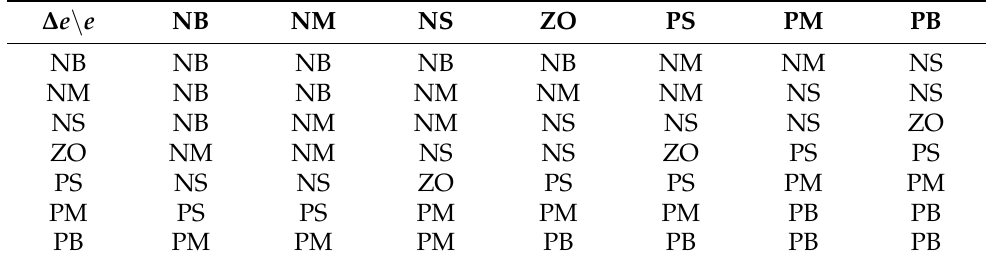
Table 2. Rule base of ∆𝐾𝑝(𝑘) .